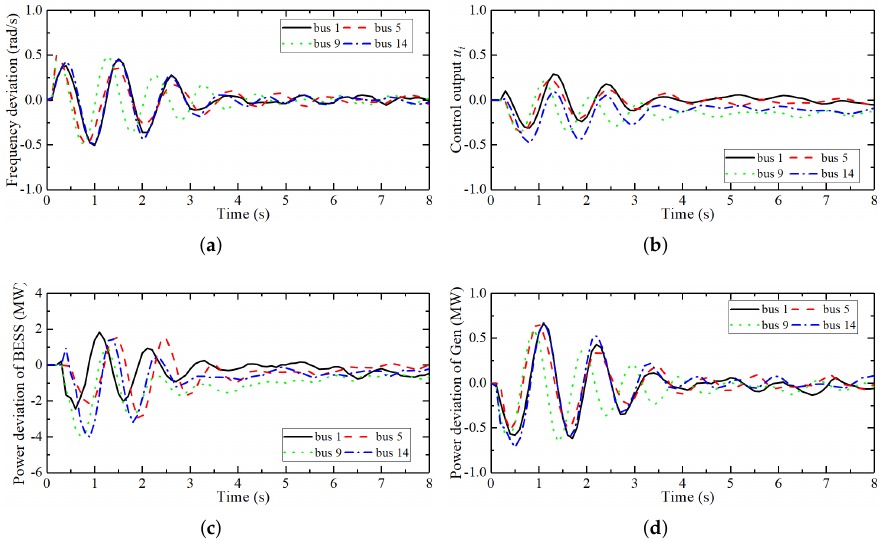
Figure 10. Frequency deviation, control output, BESS and power output deviation of the generator in IEEE14 bus testing system, η ji = 0.4. ( a ) Frequency deviation. ( b ) Control output u i . ( c ) Power deviation of BESS. ( d ) Power deviation of